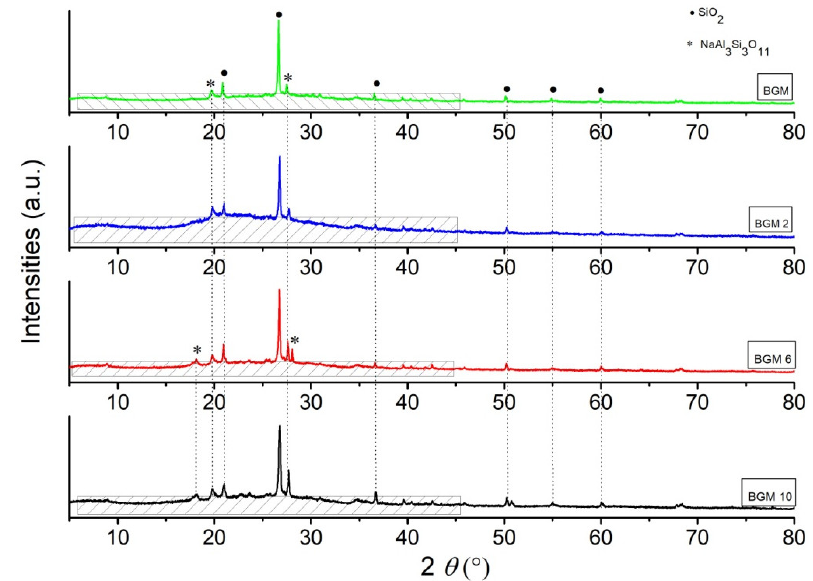
Figure 3. XRD diffraction patterns of BGM, BGM2, BGM6, and BGM10.